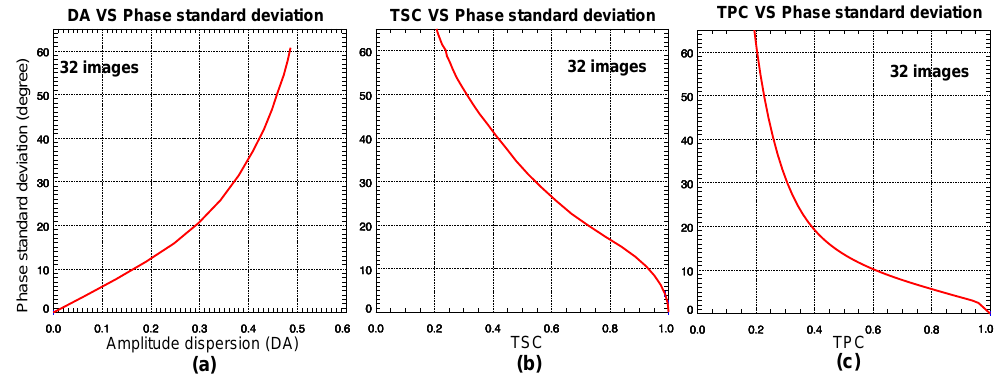
Figure 7. Standard deviation of the interferometric phase as a function of ( a ) D A , ( b ) TSC and ( c ) TPC for the 32 images